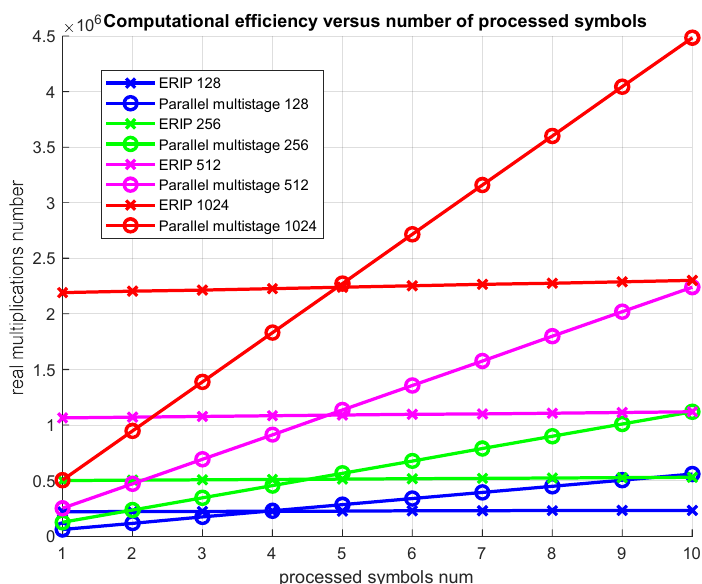
Figure 6. ERIP and parallel multistage computational efficiency versus number of processed symbols and subcarriers.